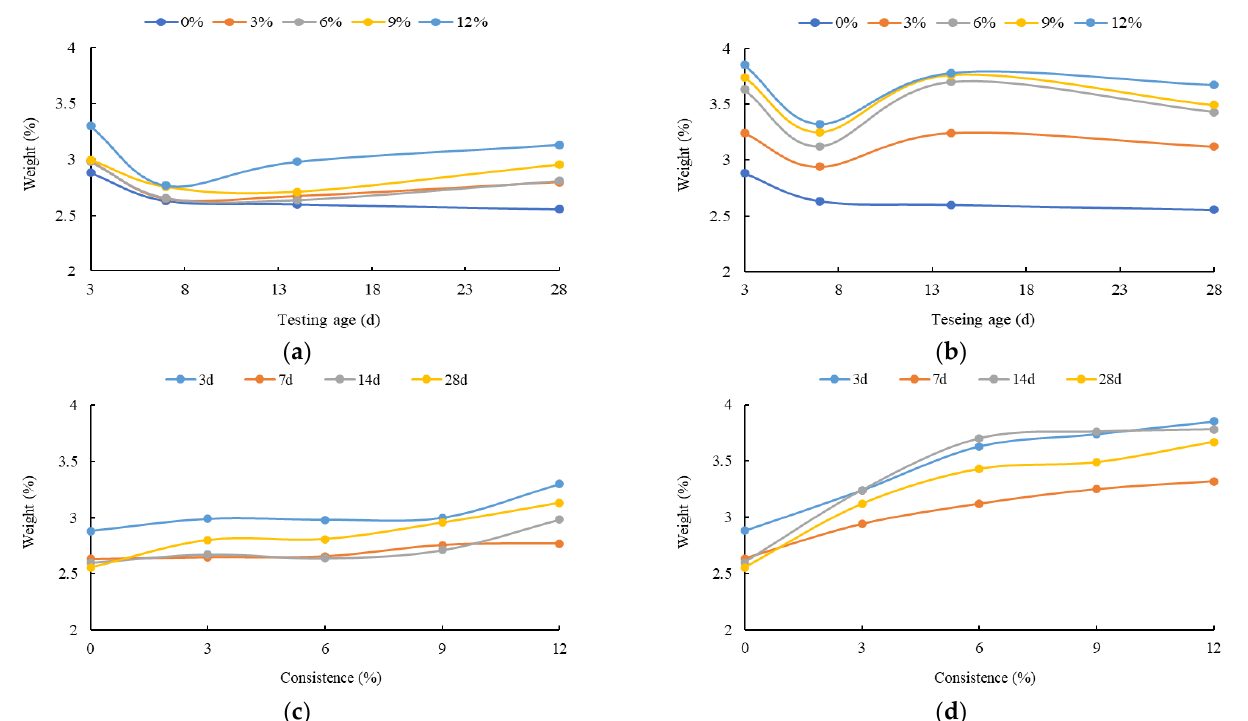
Figure 10. Mass loss rule of hydration products in the second stage of endothermic peak: ( a ) IN; ( b ) OU; ( c ) IN; ( d ) OU